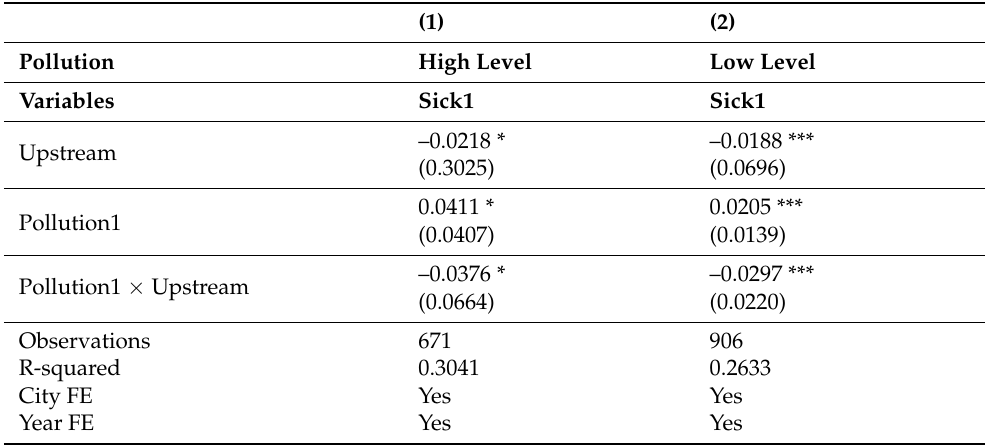
Table A7. Effect of pollutant emissions on health of residents with various health conditions.